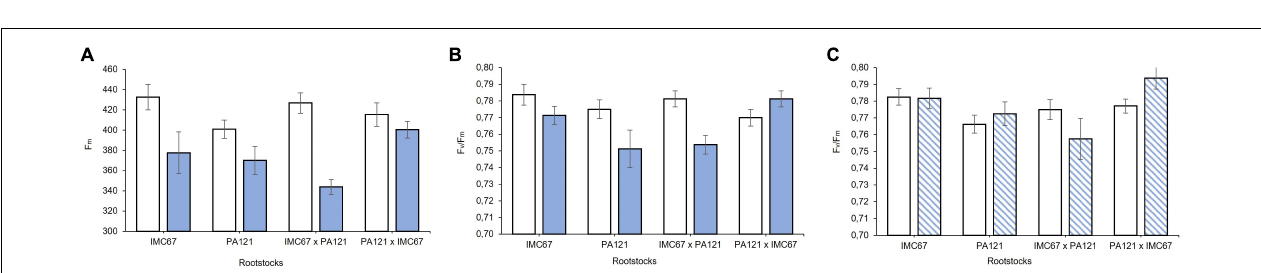
FIGURE 8 | Chlorophyll fluorescence in the ICS95 clonal scion when grafted with 4 different rootstock families at two different concentrations of Cd in soil under greenhouse conditions. (A) F m 2 months after grafting. (B) F v /F m 2 months after grafting. (C) F v /F m 4 months after grafting. White bars represent rootstock families grown in soil without addition of Cd (0.43 mg kg − 1 ). Blue bars represent rootstock families grown in Cd spiked soil (7.49 mg kg − 1 ). Dashed bars show Cd accumulation 4 months after grafting. Data are mean values ± SE ( n = 8).